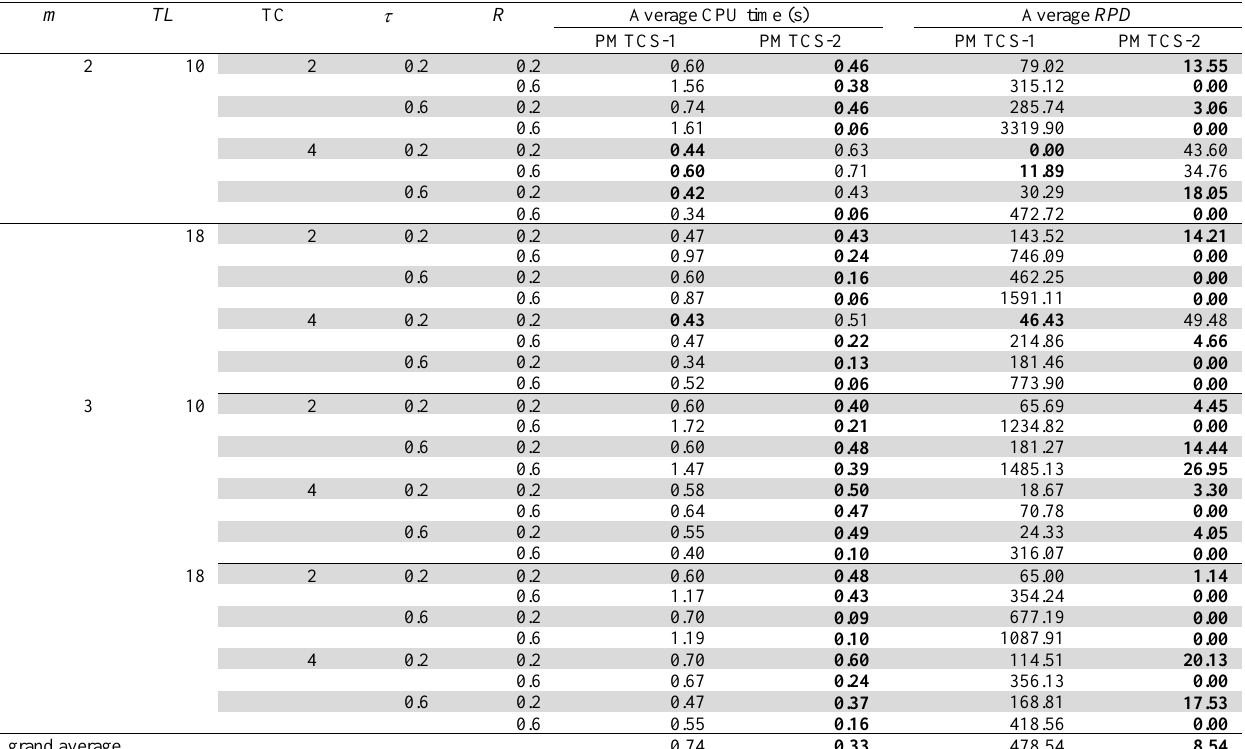
Computational results for problems with 6 jobs